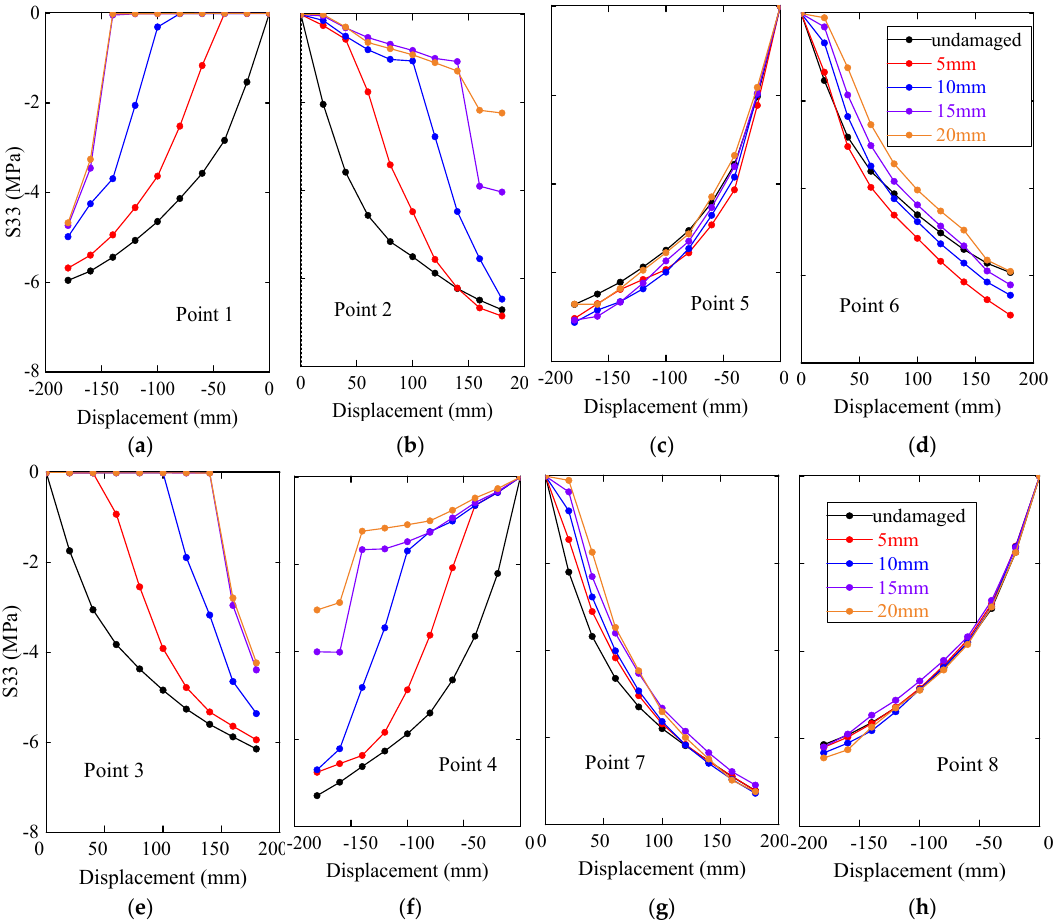
Figure 23. Envelope curves of S33: ( a ) Point 1; ( b ) point 2; ( c ) point 5; ( d ) point 6; ( e ) point 3; ( f ) point 4; ( g ) point 7; ( h ) point 8.